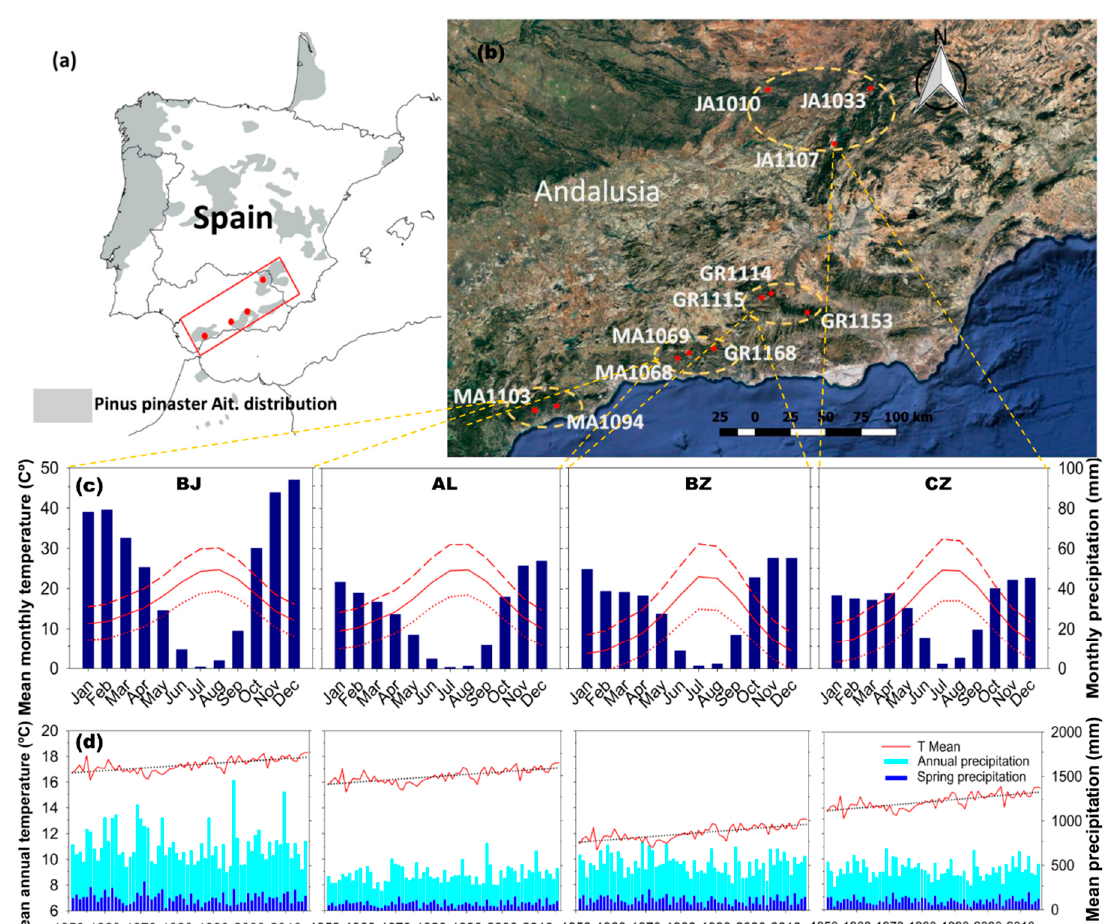
Figure 1. ( a ) Distribution of Pinus pinaster Ait. and ( b ) sampled sites (red dots) distributed in four different locations in Andalusia (southern Spain). Climatic diagrams ( c ) and trends ( d ) in the mean temperature (lines) and precipitation (bars) of the study sites (see Table 1 for the site codes), for the period 1950–2017, based on 0.25° gridded monthly data from ENSEMBLES Observations gridded dataset (E-OBS)[32].